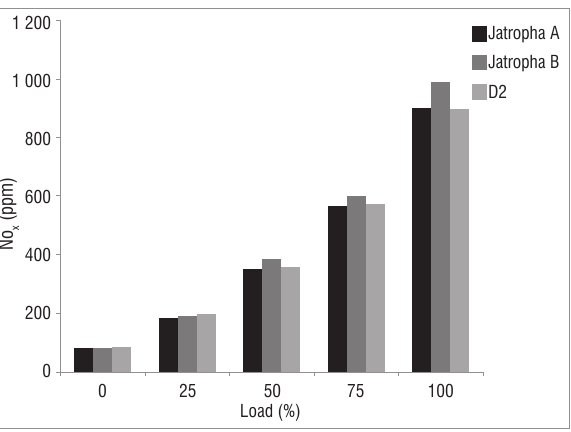
emissions for the different fuel samples at different loads. Figure 2: NO x Total hydrocarbons